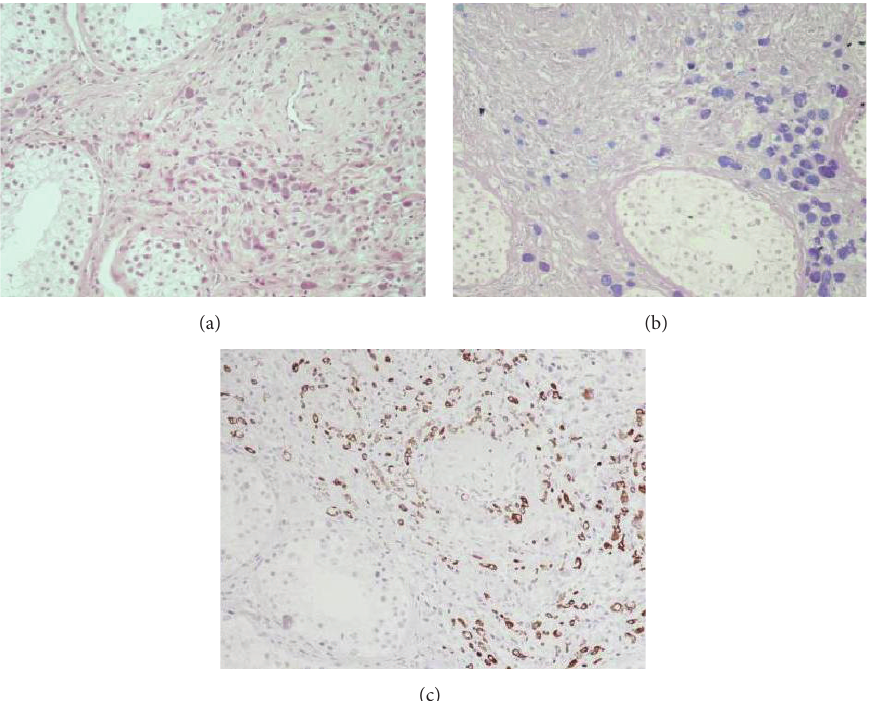
Figure 2: (a) The testicular parenchyma is infiltrated by neoplastic signet-ring cells (hematoxylin-eosin × 200). (b) Tumor cells exhibit positivity for mucin stains (arrows). (c) Immunohistochemically the tumor cells were positive for cytokeratin 20